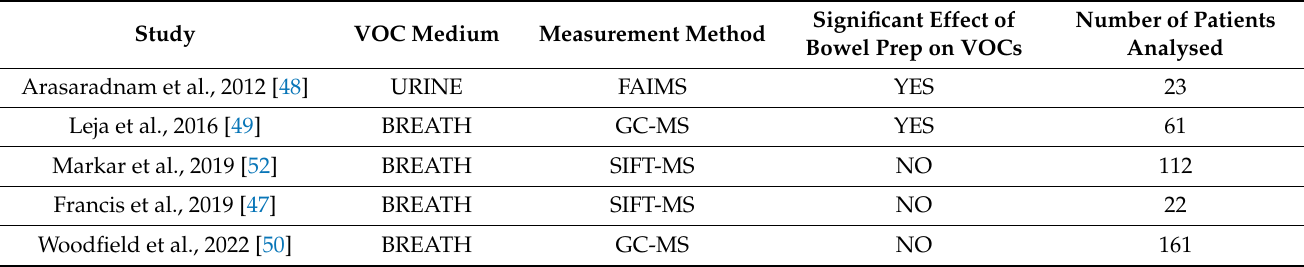
Table 1. Summary of VOC media, compounds, and effects of bowel prep on VOCs.